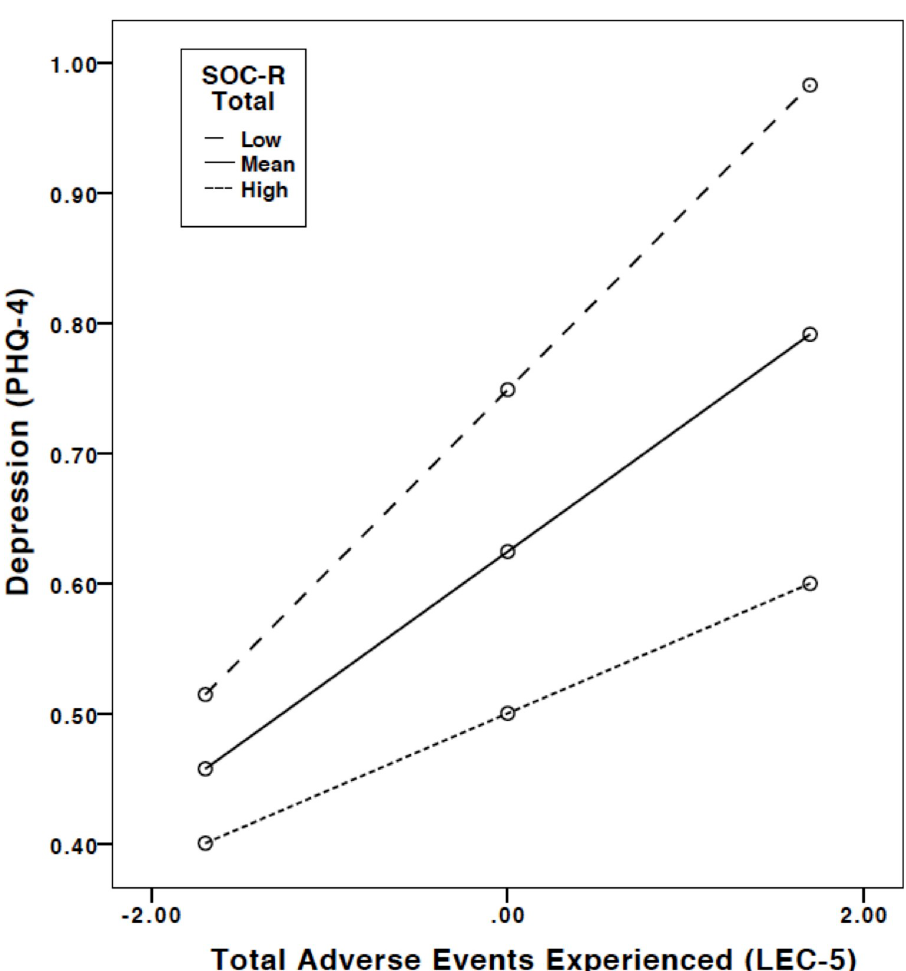
Fig 4. Plot of the regression of total adverse events experienced on depression at different levels of the moderator (SOC-R). Note: High and low levels refer to one standard deviation above and below the mean value of the moderator (i.e.